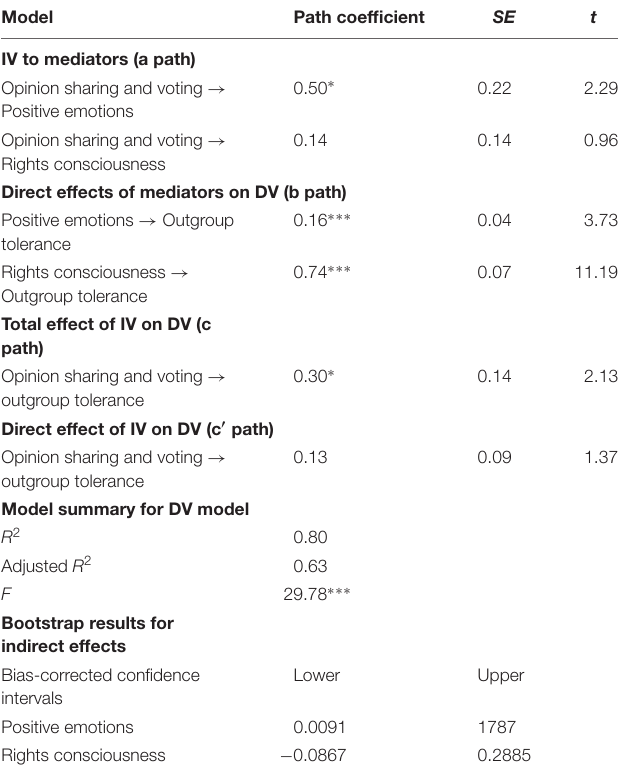
TABLE 2 | Results of multiple mediation analyses on outgroup tolerance: Study